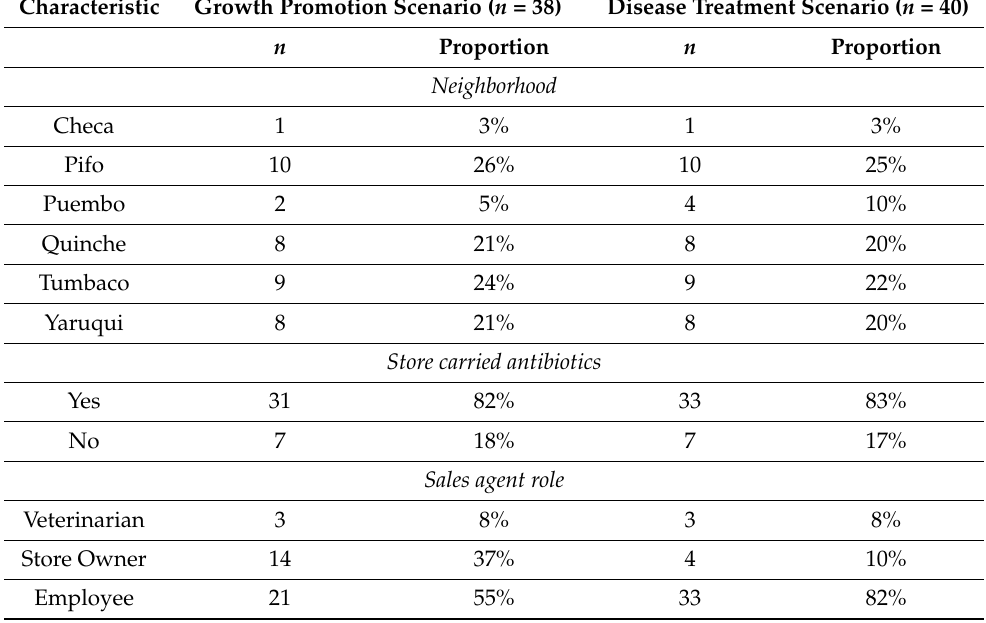
Table 2. Simulated client method participants in the growth promotion scenario and disease treat- ment